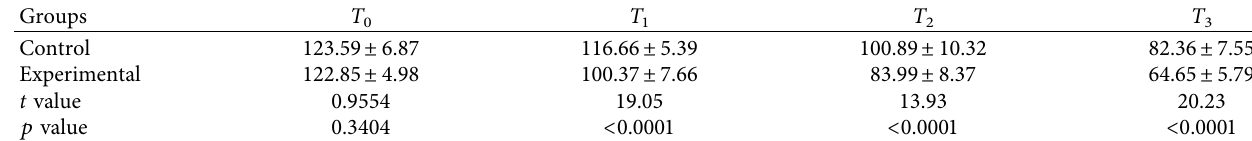
Table 4: The horizontal comparison of NGAL between two groups at different time points ( x ± S , μ g/L).